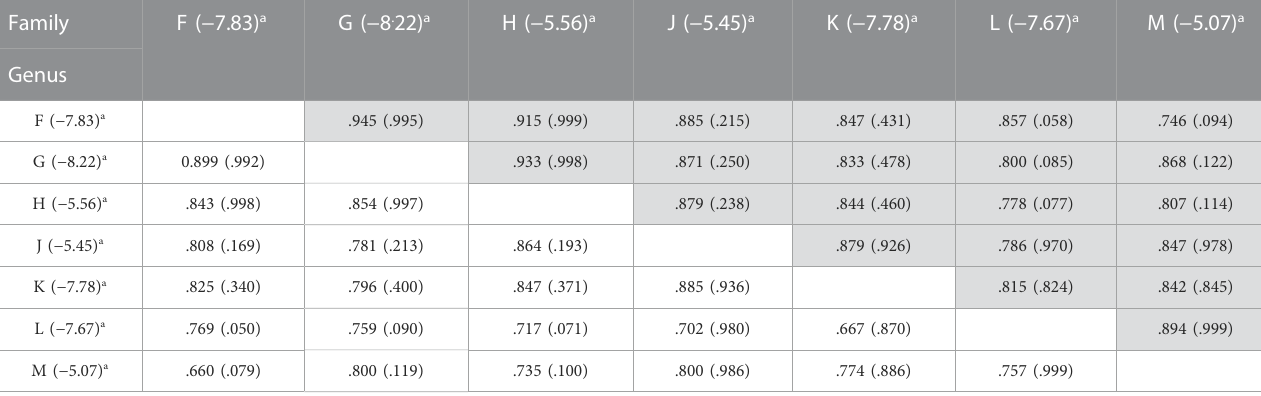
TABLE 5 Similarity in the bacterial composition of commercial lots produced from seeds E (F – H) and I (J – M) as de fi ned by Sørensen ’ s coef fi cient and simple correlation ( ).